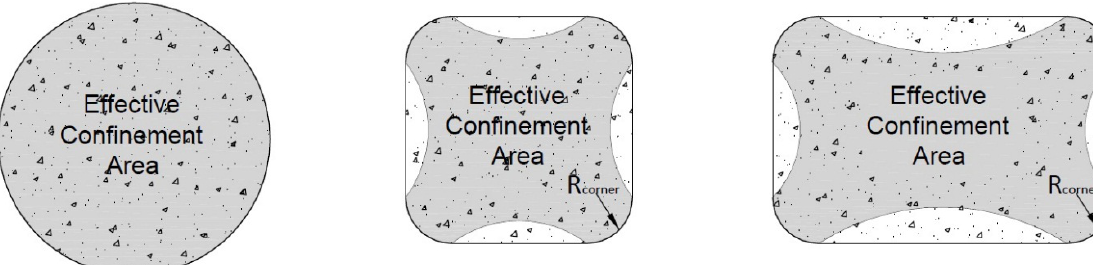
Figure 1. Effective confinement areas in circular, square and rectangular